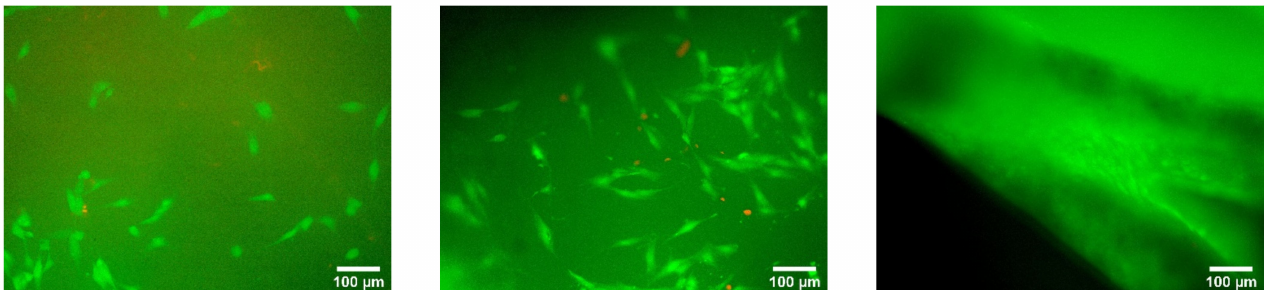
Figure 9. Fluorescence microscopic images of the surface of the 200 µ m wave PBS sample with 10 × magnification, showing dead cells (red) and living cells (green); from left to right: days 3, 7, and 10. Images taken with an Olympus BX-53 fluorescence microscope.